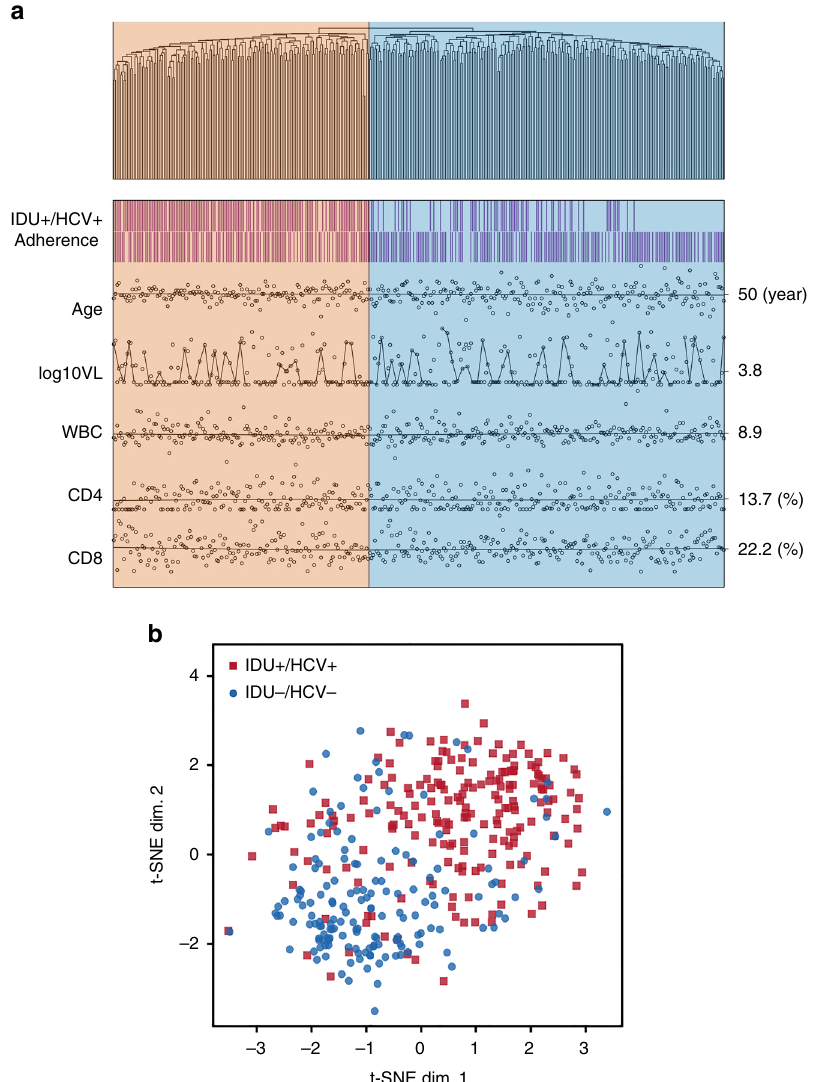
Fig. 3 A penal of DNA methylation CpG sites clusters injection drug use with hepatitis C and non-injection drug use without hepatitis C in HIV-infected individuals. a Hierarchical clustering analysis of 748 CpG methylation sites in 386 HIV-infected individuals in the discovery sample set. Two clusters differentiated between injection drug use with HCV (IDU+/HCV+) and non-injection drug use without HCV (IDU − /HCV − ), but clusters were not associated with other factors including adherence of antiretroviral treatment, age, HIV-1 viral load, and cell-type compositions ( p' s > 0.1). b t-distributed stochastic neighbor embedding (t-SNE) clustering analysis shows that 748 CpG methylations differentiated injection drug use with HCV infection (IDU+/HCV+) from non-injection drug use without HCV (IDU − /HCV − ) in the discovery